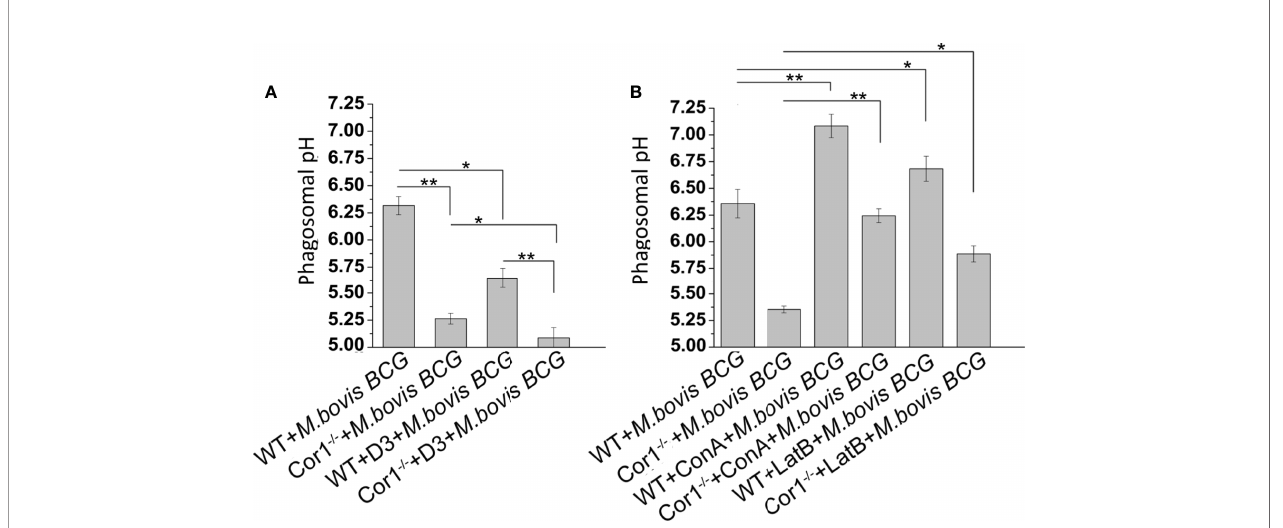
FIGURE 6 | Phagosome pH was monitored using pHrodo in WT and Cor1 -/- BMDM upon being either (A) kept untreated or D3 pretreated before infection with M. bovis BCG for 3 h. (B) Similarly, WT or Cor1 -/- macrophages were either kept untreated or pretreated with either ConA or LatB before infection with M. bovis for 3 h, followed by measurement of phagosome pH. The phagosome pH values were obtained from the standard curve generated using pHrodo in different pH buffers. Data represents mean ± SEM; * p < 0.05, ** p <